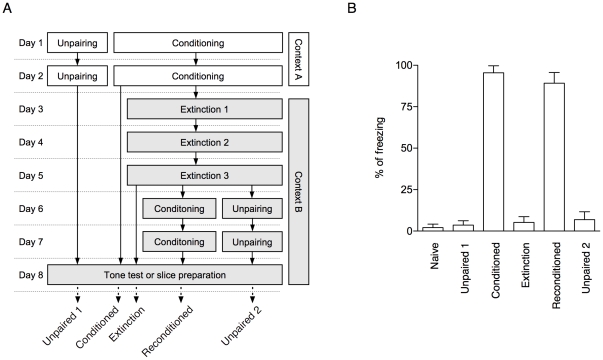
Behavioral procedures.
A. Schematic diagram for behavioral procedures. Conditioning was carried out for two consecutive days, followed by extinction (three days) and reconditioning (two days) in a distinct context. White and gray tones in the rectangles represent context A and B, respectively. On day eight, brain slices were acquired from rats, while a separate set of animals were tested for fear memory retention. B. Pooled behavioral results for Fig. 2 and 3.